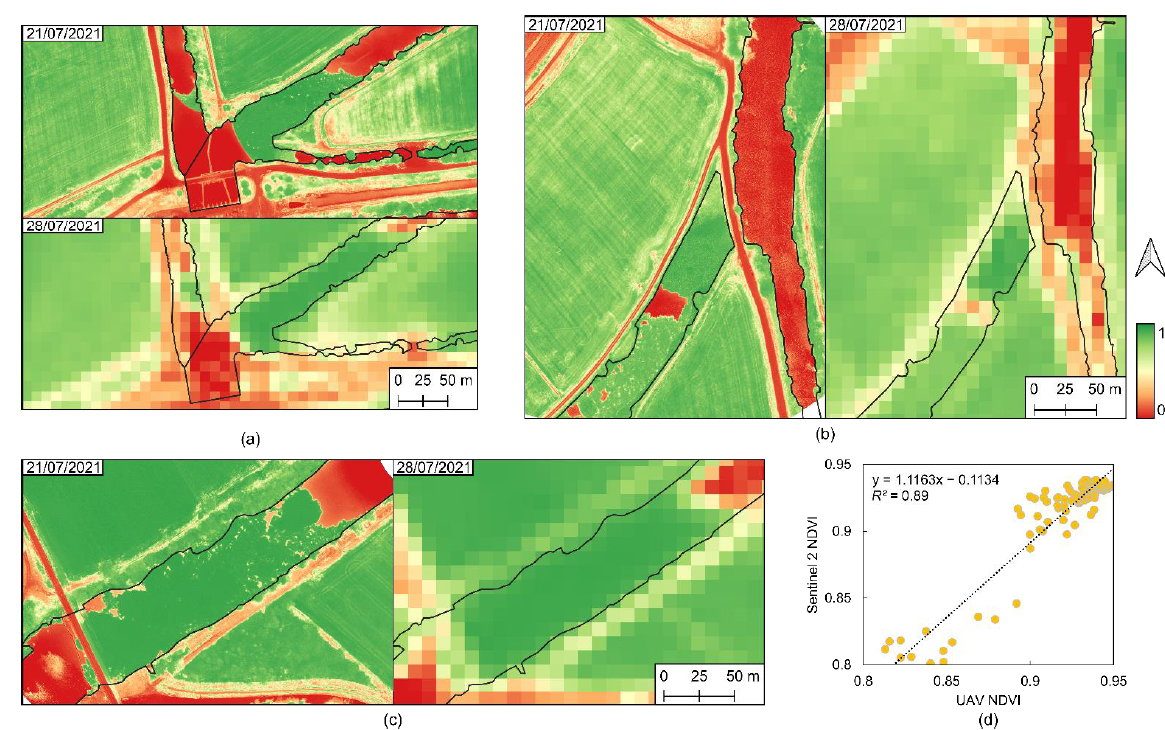
Figure 2. Normalized difference vegetation index (NDVI) of area 1 ( a ), area 2 ( b ) and area 3 ( c ) surveyed by the unmanned aerial vehicle (UAV) on 21 July 2021 and by Sentinel-2 on 28 July 2021, and ( d ) the linear correlation of water hyacinth NDVI pixels obtained from Sentinel-2 and UAV. Table 2. Water hyacinth detected area (m 2 ) type (correct, over, and under) when using the normalized difference vegetation index (NDVI) and when applying a random forest (RF) in the three areas surveyed by the unmanned aerial